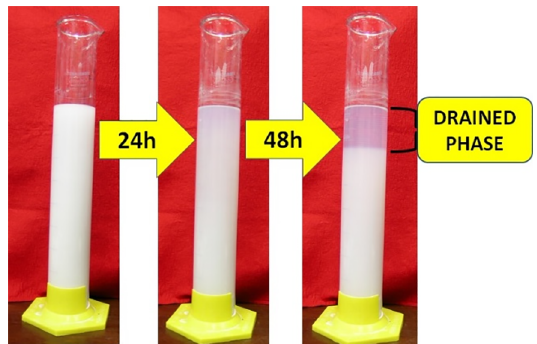
Figure 3. Decanting process. After 48h, the translucent phase is drained and the water is evaporated, forming a powder containing submicron